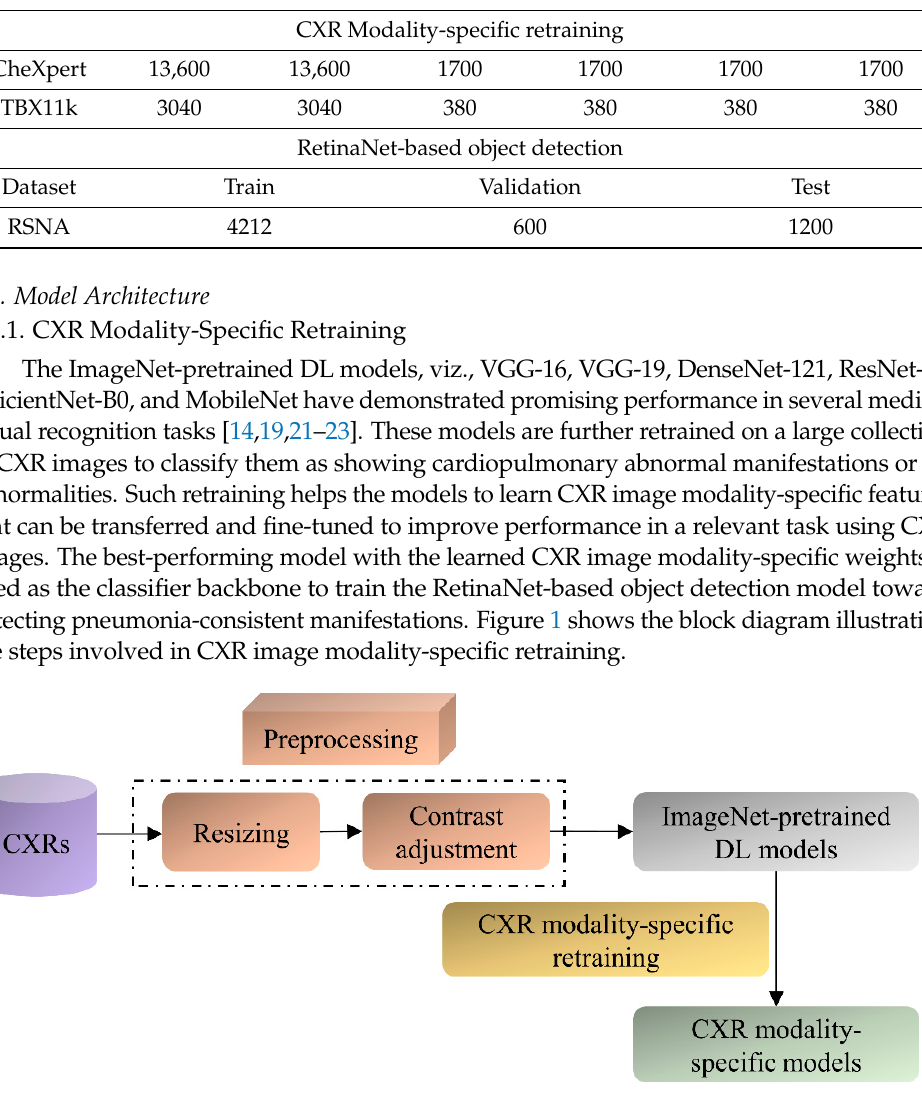
Figure 1. Steps illustrating CXR image modality-specific retraining of the ImageNet-pretrained